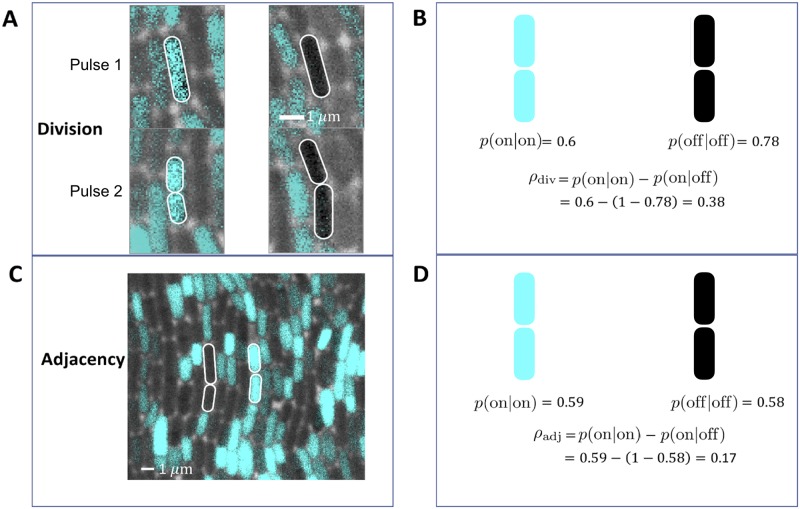
Order parameter ρ quantifies degree of spatial correlations.(A, B) Lineage-tracing experiments yield ρdiv = 0.38 (N = 49 division events). (C, D) Spatial analysis of the biofilm images yield ρadj = 0.17 (N = 51 cell pairs).